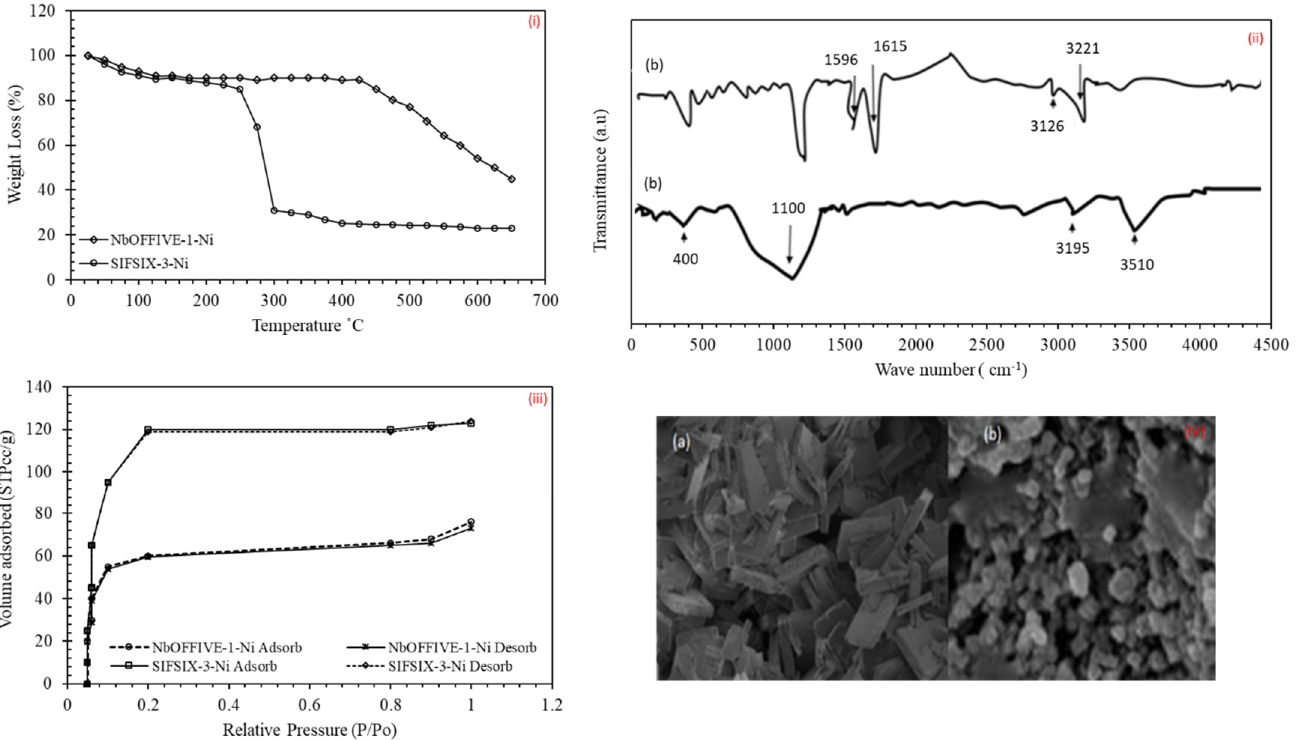
Figure 2. Characterization results for SIFSIX-3-Ni and NbOFFIVE-1-Ni; ( i ) TGA; ( ii ) FTIR; ( iii ) N 2 adsorption/desorption; ( iv ) SEM images ( a ) NbOFFIVE-1-Ni, ( b ) SIFSIX-3-Ni.